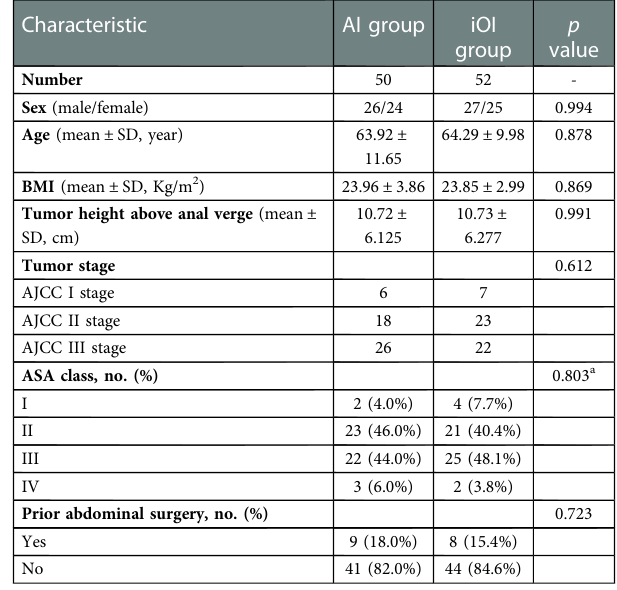
TABLE 1 Comparison of the baseline characteristics of the study